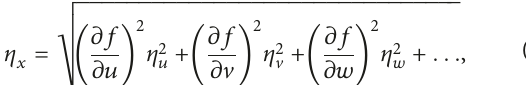
2 content in feed gas on the water